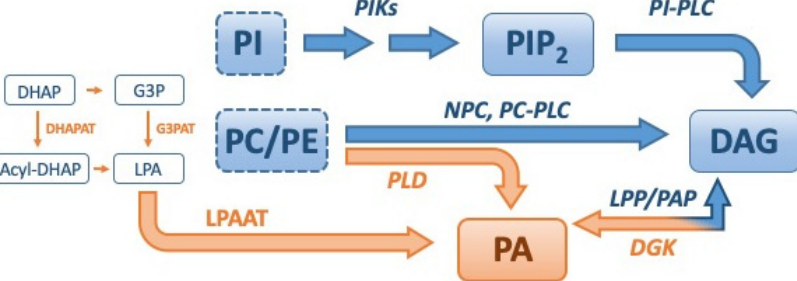
Figure 3. Representative pathways involved in the metabolism of diacylglycerol (DAG) and phosphatidic acid (PA). The biosynthetic pathways of DAG and PA are shown in blue and orange, respectively. The key enzymes of the DAG and PA biosynthetic pathway are shown in blue and orange italics, respectively. The enzyme inhibitors are represented in green font. The pathways involved in the degradation of DAG and PA are shown in black font. AT, acyltransferase; DHAP, dihydroxyacetone-3-phosphate; G3P, glycerol-3-phosphate; LPA, lysophosphatidic acid; LPAAT, LPA acyl transferase; LPP, lipid phosphate phosphatase; NPC, non-specific phospholipase C; PAP, phosphatidic acid phosphatase; PC, phosphatidylcholine; PE, phosphatidylethanolamine; PI, phosphatidylinositol; PIK, phosphatidylinositol kinase; PLC, phospholipase C; PLD, phospholipase D. Protein kinase C (PKC) is activated by sn-1,2 DAG [18,33,34]. Additionally, PKC interacts with